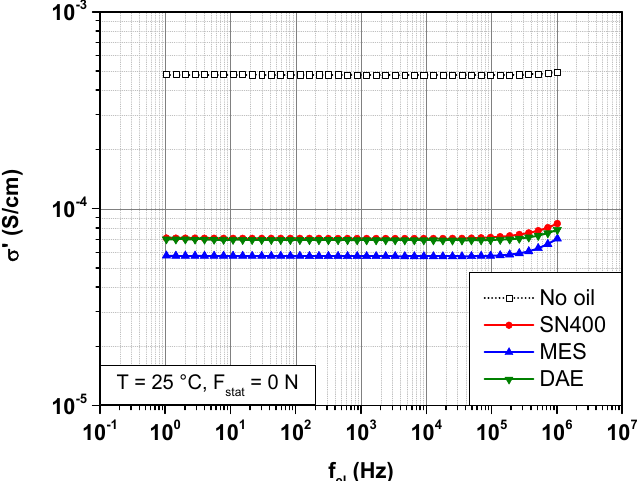
Figure 3. Frequency-dependent change of the real part of the conductivity σ (cid:48) of SBR samples with Figure 3. Frequency ‐ dependent change of the real part of the conductivity 𝜎 (cid:4593) of SBR samples with different plasticizers at 25 °C. different plasticizers at 25 ◦ Figure 3 indicates that the real part of the conductivity 𝜎 (cid:4593) of the SBR sample without plasticizer hardly shows any changes within the frequency range of the measurements. A direct current conductivity 𝜎 (cid:3031)(cid:3030) of 4.8 × 10 − 4 S/cm is recorded. It is to note that this high conductivity in carbon black filled rubber is clearly related to the carbon black network. At a filler concentration of 60 phr, the mechanical percolation threshold is exceeded, resulting in a network of interconnected filler clusters. The contribution of polymer chains to the conductivity of SBR samples is approximately ten orders of magnitude less. The oil ‐ extended SBR samples show at least two disparities compared with the SBR sample without plasticizer. First, the real part of the conductivity 𝜎 (cid:4593) is from an electrical frequency of 100 kHz frequency ‐ dependent, regardless of the polarity of the plasticizer used. 𝜎 (cid:4593) increases with increasing frequency. Second, the direct current conductivity 𝜎 (cid:3031)(cid:3030) becomes smaller. It is 7 × 10 − 5 S/cm for the SBR samples with 20 phr SN400 and DAE. For the SBR samples with 20 phr MES, 𝜎 (cid:3031)(cid:3030) is 5.8 × 10 − 5 S/cm. In this context, it is worthy to note that the polarity of the plasticizer has no big influence on the conductivity. The addition of plasticizer has only influenced the distribution of the filler clusters within the rubber matrix. As a result, the distances covered by the free charge carriers along the electric field lines become longer. 5.2. Simultaneous Mechanical and Dielectric Analysis Dielectric measurements on the SBR samples are carried out at room temperature under a static force of 10 N. The latter corresponds to a mechanical stress of 0.127 MPa. Figure 4 shows the frequency ‐ dependent change in the real part of the conductivity 𝜎 (cid:4593) of the SBR samples with and without plasticizers.